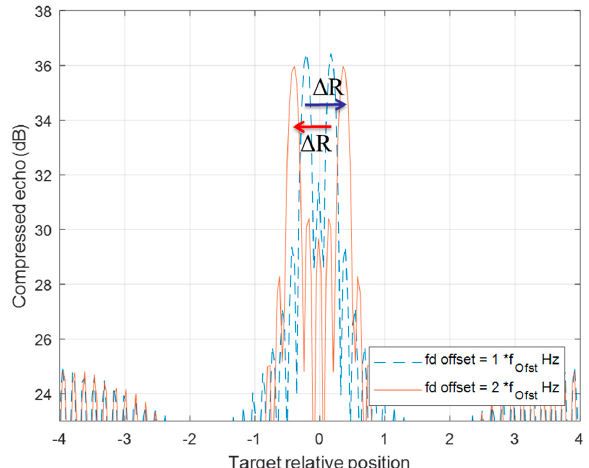
Figure 9. The range offset of a two-chirp detection pair of a moving target is processed by two f d _offset DSC. Two detection lines crossover each other from one f d _offset DSC (blue-dotted line) to two f d _offset DSC (red line) with the same Δ R offset in opposite direction.